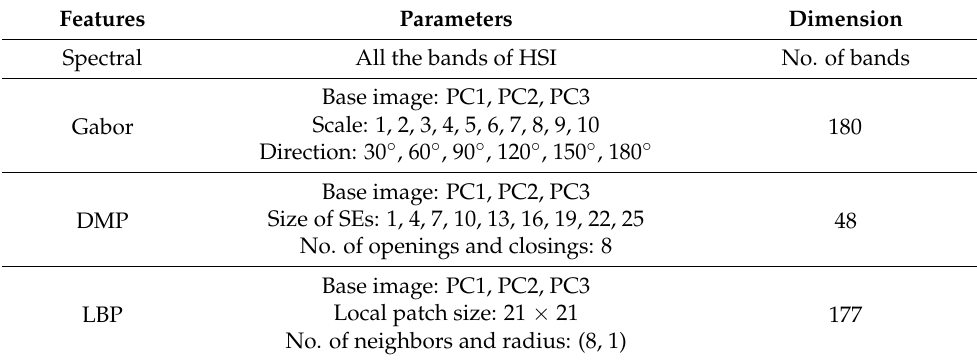
Table 4. Parameter setting for multiple feature descriptors.